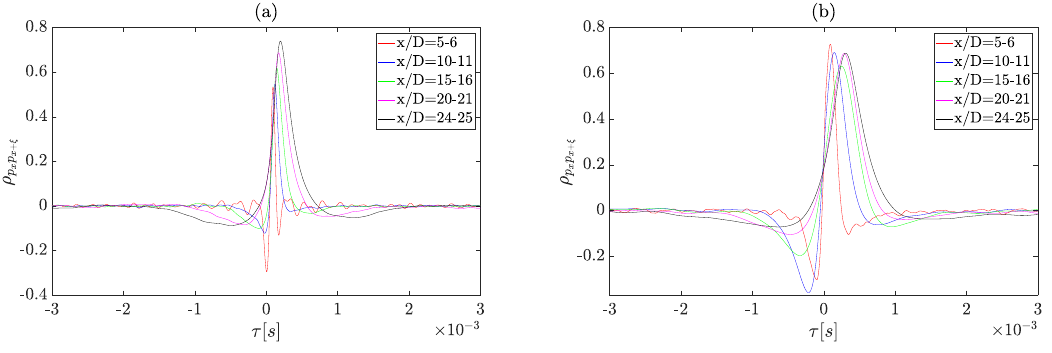
Figure 5. Axial evolution of the wall pressure cross-correlation coefficient at M j = 0.5: ( a ) H/D = 0.75; ( b ) H/D = 2.